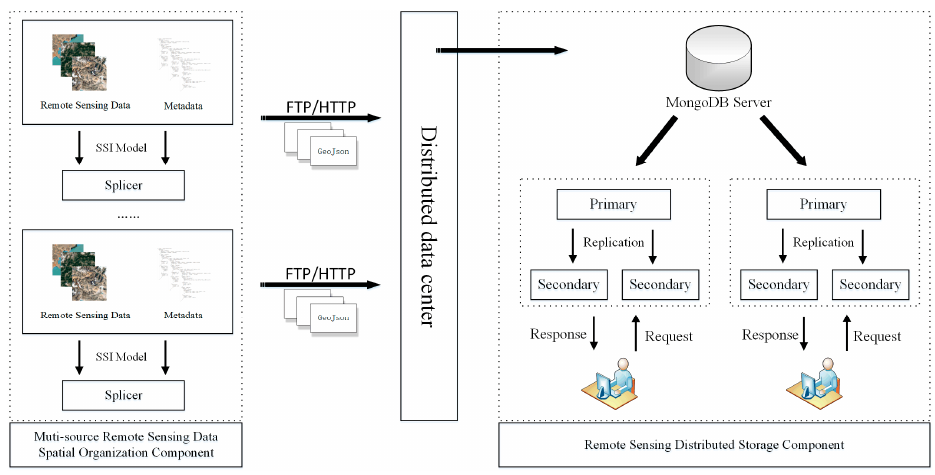
Figure 1. Architecture of the proposed method.